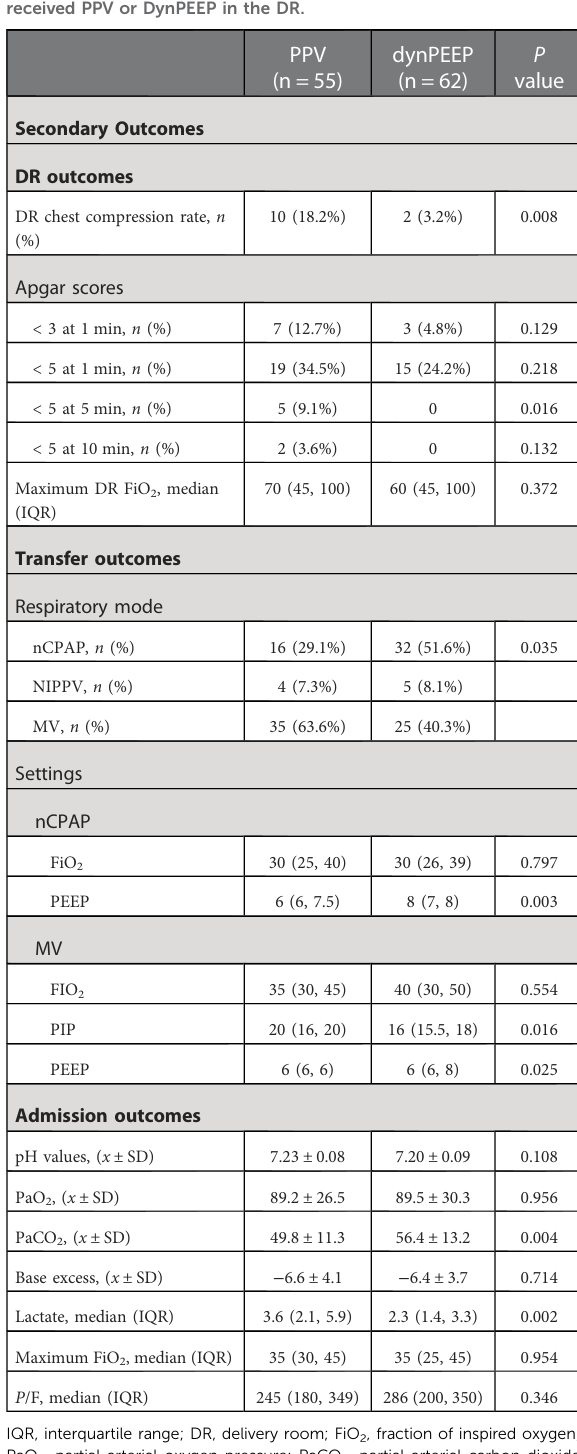
TABLE 1 Baseline maternal and neonatal demographic and clinical characteristics.